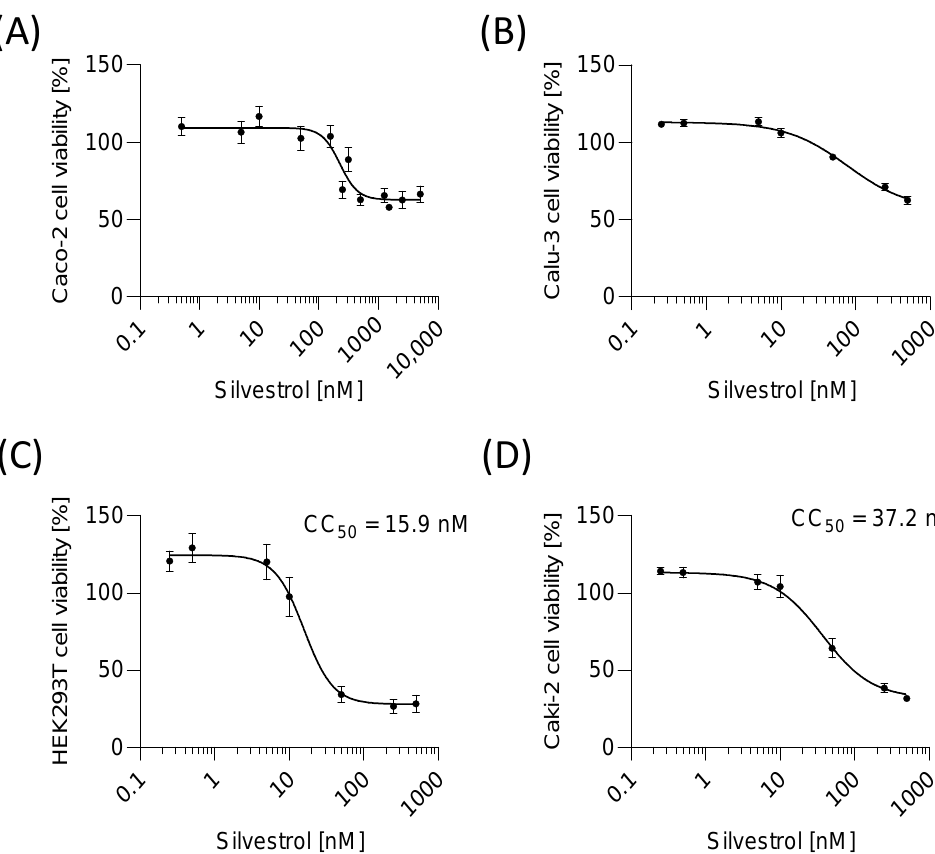
Figure 1. Impact of silvestrol on cell viability. For the cell viability assay, Caco-2 ( A ), Calu-3 ( B ), HEK293T ( C ) and Caki-2 ( D ) cells were incubated with various concentrations of silvestrol over a time period of 48 h. The absorbance of DMSO-treated cells was set to 100% and samples treated with silvestrol were correlated to the absorbance of the respective DMSO value to calculate cell viability. The experiments were performed in biological and technical triplicates. Data are expressed as mean ± SEM. The CC 50 values were calculated with a non-linear fitting model using GraphPad Prism Version 8.4.3 (GraphPad Software, San Diego, CA, USA) only for HEK293T and Caki-2 cells because in Caco-2 and Calu-3 cells silvestrol did not reduce viability below 50%.